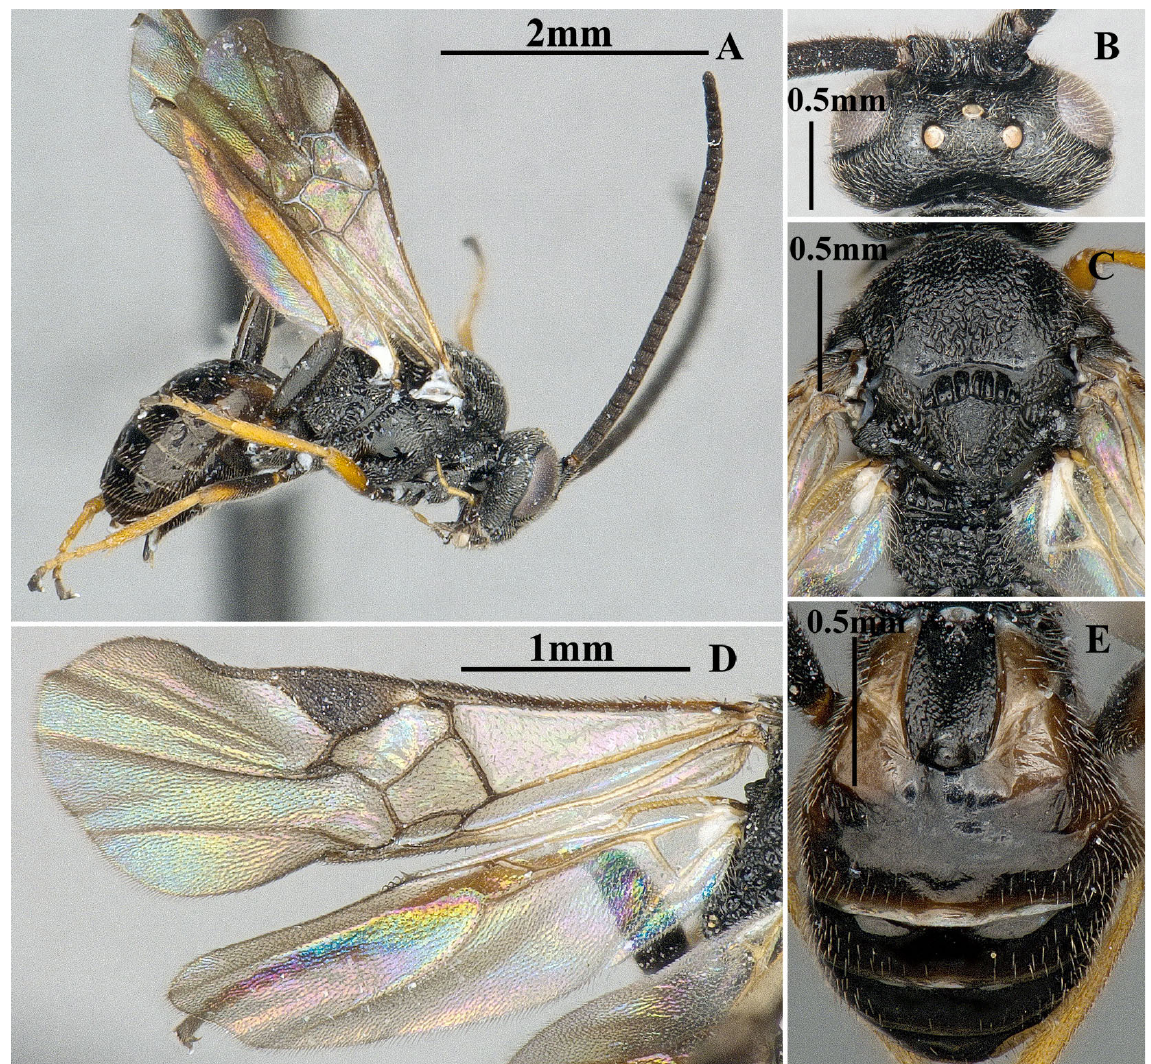
Fig. 3. Microplitis cebes Nixon, 1970, ♀, TMUC-HBMMP0007. A . Habitus, lateral view. B . Head, dorsal view. C . Mesosoma, dorsal view. D . Wings. E . Metasoma, dorsal